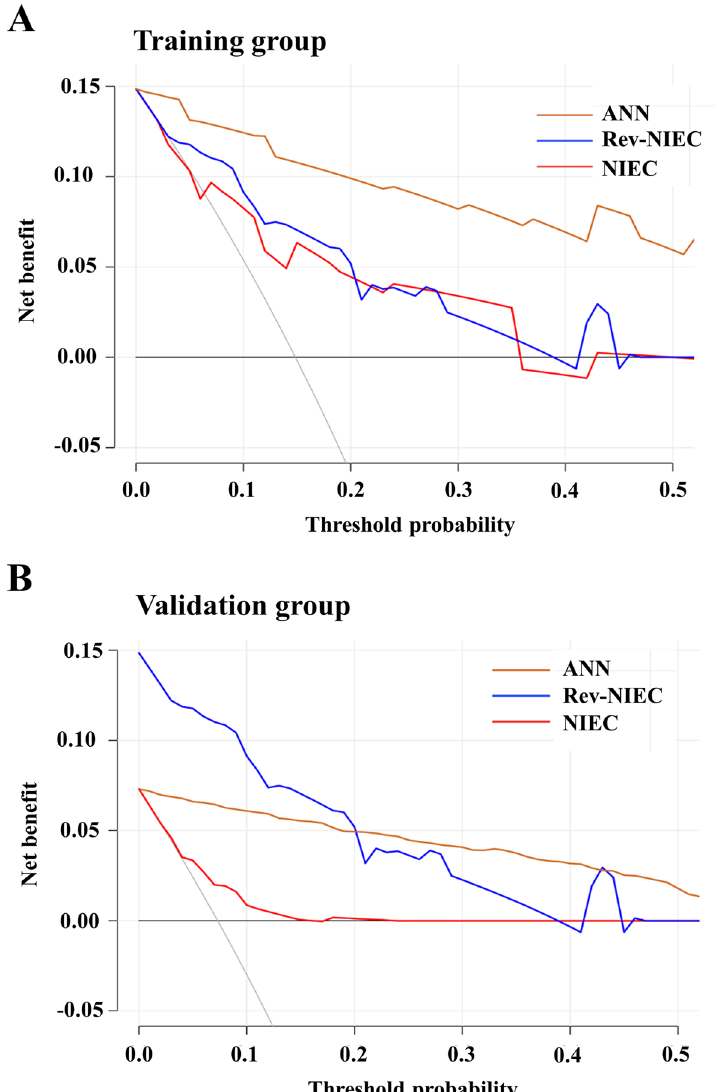
Fig. 4 Decision curve analyses for predicting the incidence of gastroesophageal variceal bleeding in the training ( A ) and validation ( B )